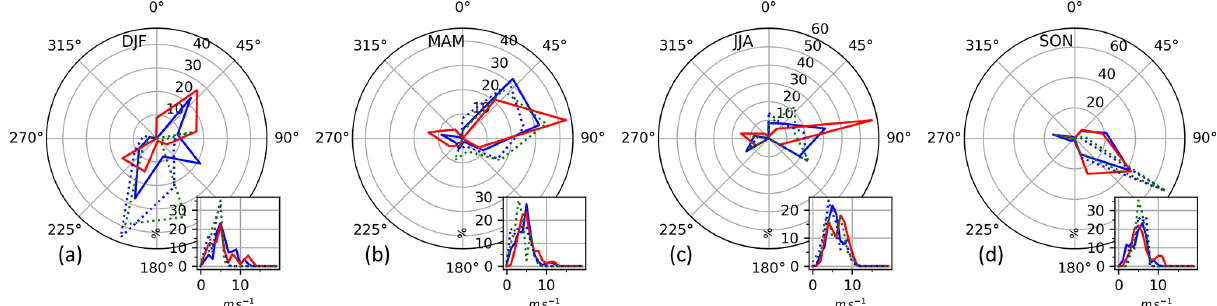
Figure 10. Seasonal RFDs (radii, [%]) of near-surface wind direction [degrees] within 1h after cloud dissipation (solid red) and within 1h of low cloud/fog formation (solid blue) for (a) DJF, (b) MAM, (c) JJA and (d) SON. Wind direction RFDs within 1h surrounding fog formation events only are shown as dashed lines (blue is 1h prior to and green is 1h after fog formation). Insets in each panel show the RFD of wind speed [ms − 1